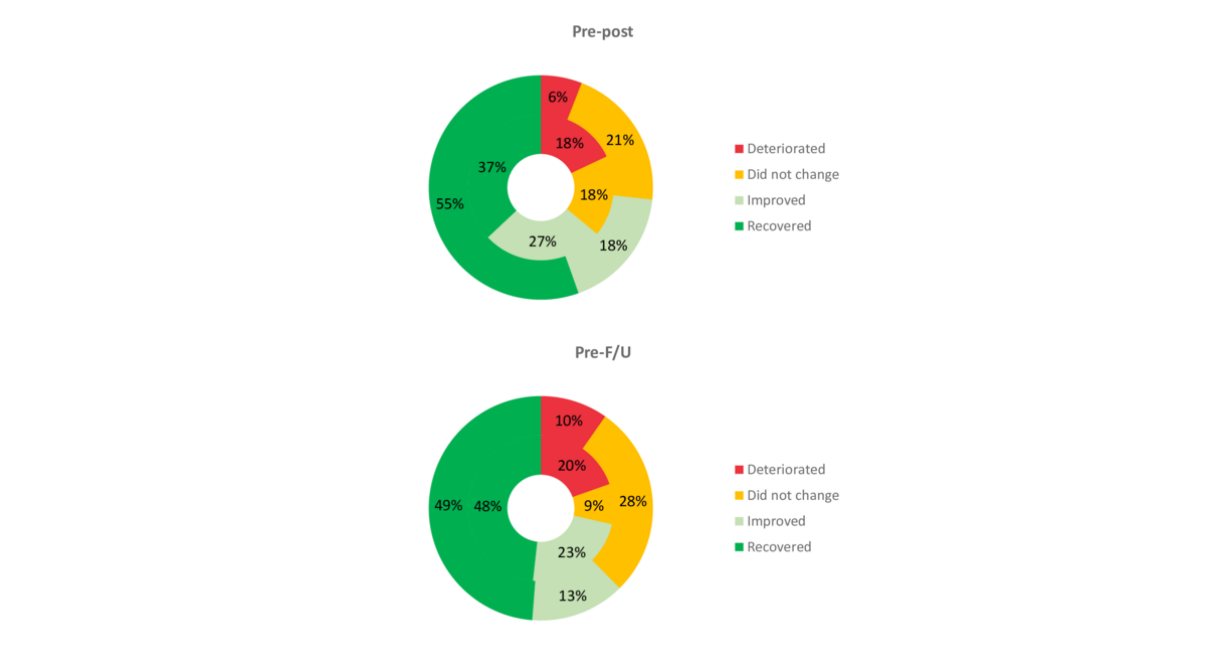
Figure 3. Percentages of participants recovered, improved, did not change, and deteriorated on anxiety scores (Beck anxiety inventory) in EmotionRegulation (outer circle) and treatment as usual (inner circle). F/U: follow-up.